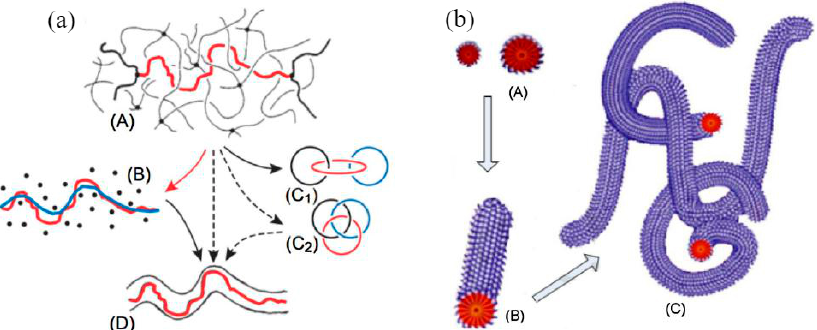
Figure 3. Microstructure of polymer drag reducer and surfactant in the fluid: ( a ) high-molecular polymer solution [23]; ( b ) surfactant solution [24].